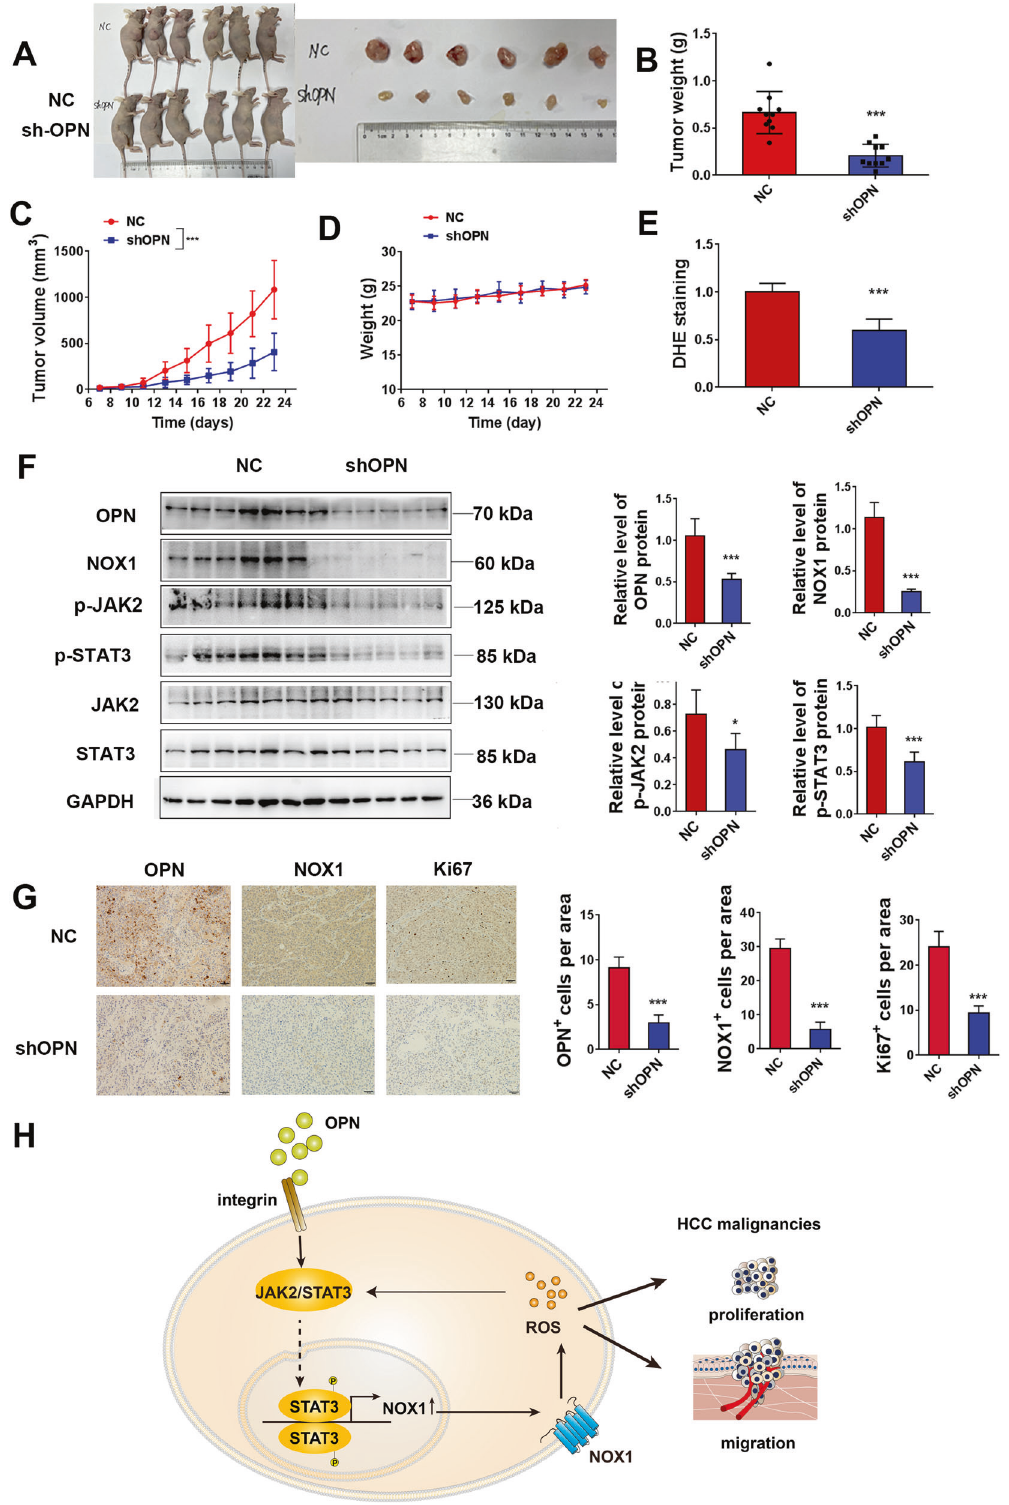
Fig. 7 OPN depletion suppresses ROS production, NOX1 expression, and xenograft growth in vivo. A – D Nude mice (ten per group) were injected with negative control or shOPN HCCLM3 cells. The mice were killed after 23 days of injection, and the tumors were excised and weighed ( B ). The volume of the tumors ( C ) were measured every other day for an indicated 23-day period. D The effect of OPN knockdown on the body weight of mice. E The level of ROS in the tumor tissue was assayed by DHE. F Western blot analyses of NOX1, pJAK2, and pSTAT3 expressions in the subcutaneous tumor ( n = 6). G Immunohistochemistry of tumor tissues stained with OPN, NOX1, and Ki67 antibodies ( n = 6). Quanti fi cation is on the right side. Original magni fi cation, ×200 (scale bars: 50 μ m). Data indicated mean ± SD. * P < 0.05, ** P < 0.01, *** P < 0.001. H Schematic representation of the role and mechanism of OPN-induced ROS in HCC.